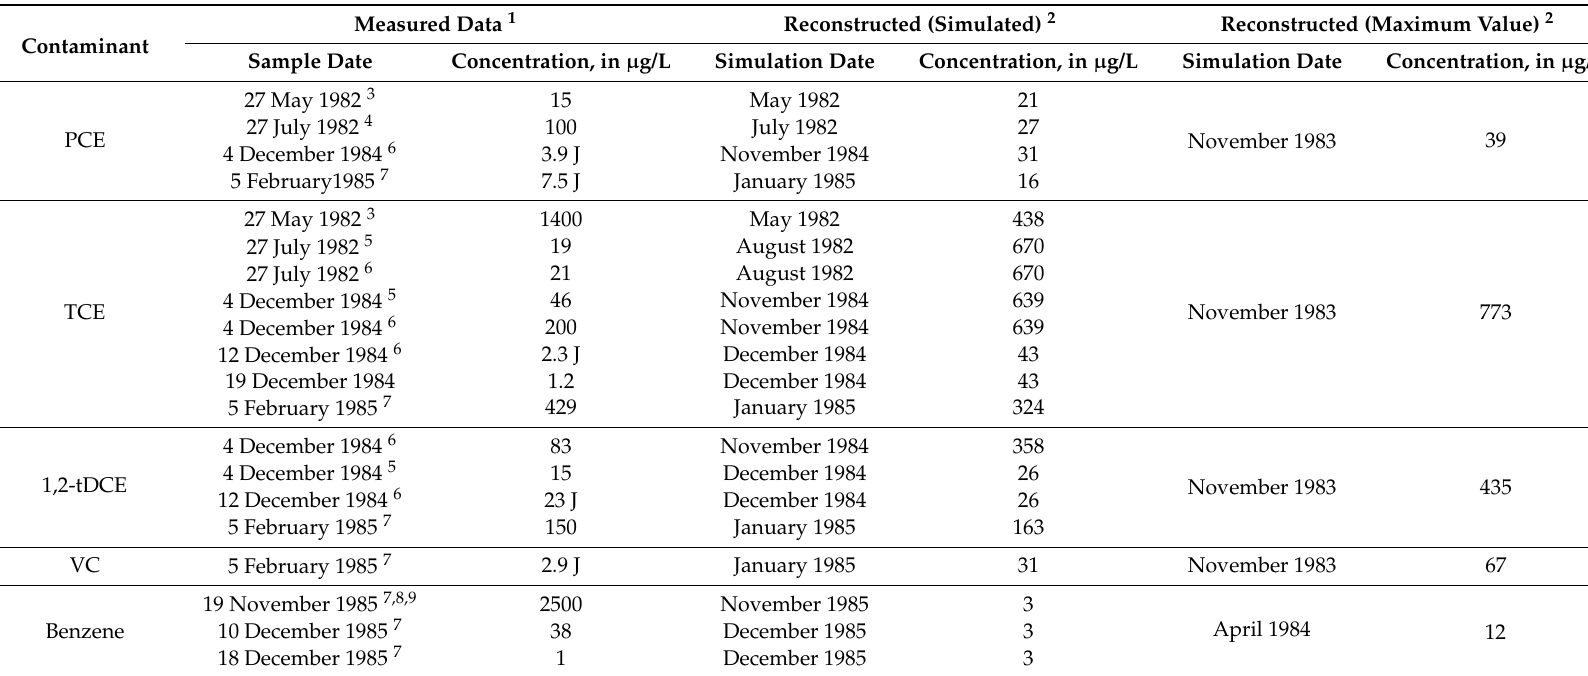
Table 2. Selected measured and reconstructed (simulated) concentrations of tetrachloroethylene (PCE), trichloroethylene (TCE), trans -1,2-dichloroethylene (1,2-tDCE), vinyl chloride (VC), and benzene at the Hadnot Point water treatment plant, U.S. Marine Corps Base Camp Lejeune, North